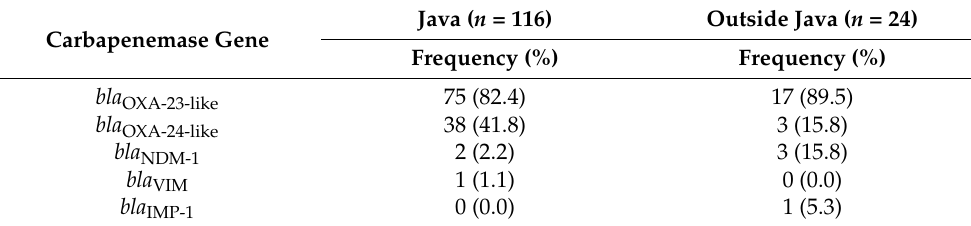
Table 3. Distribution of carbapenemase genes in CNSAB isolates based on geographics (Java vs. outside Java).